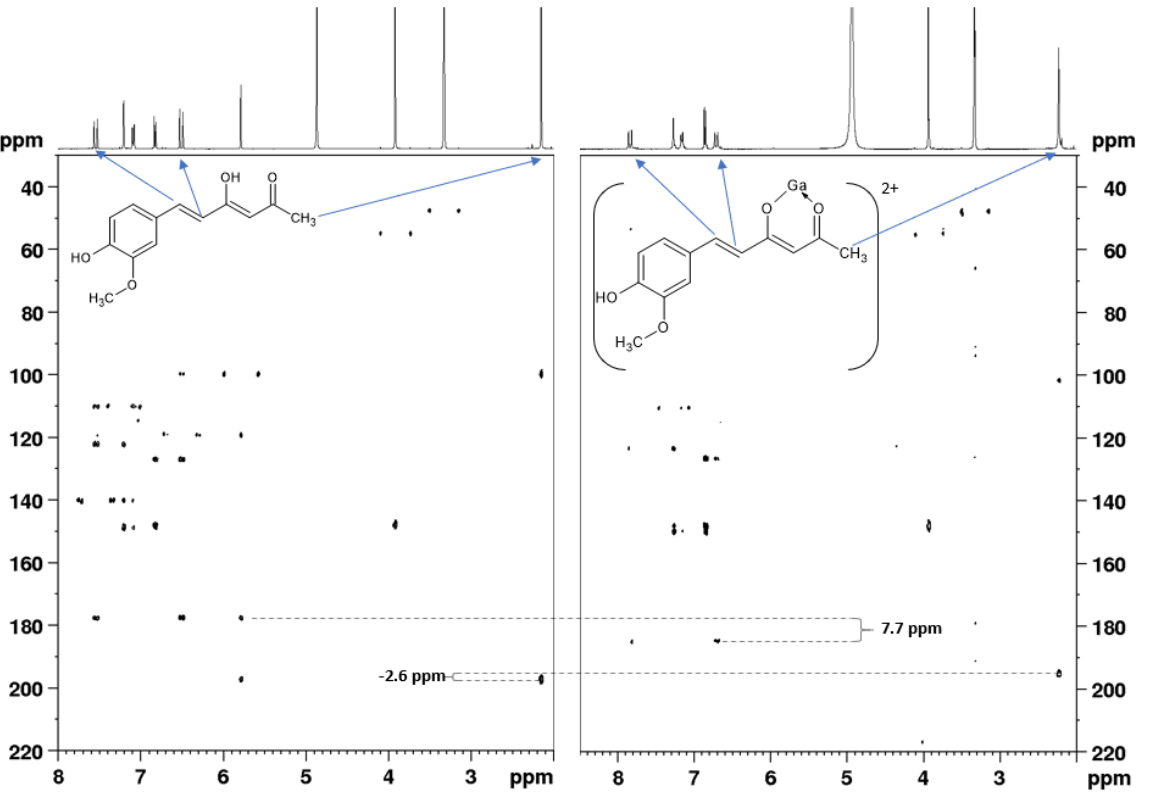
Figure 8. 1 H, 13 C HMBC NMR spectra in MeOD- d 4 at 298 K (at 600 MHz) of compound 1 ( left ) and its gallium(III) complex with the metal-to-ligand 1:1 molar ratio ( right ).